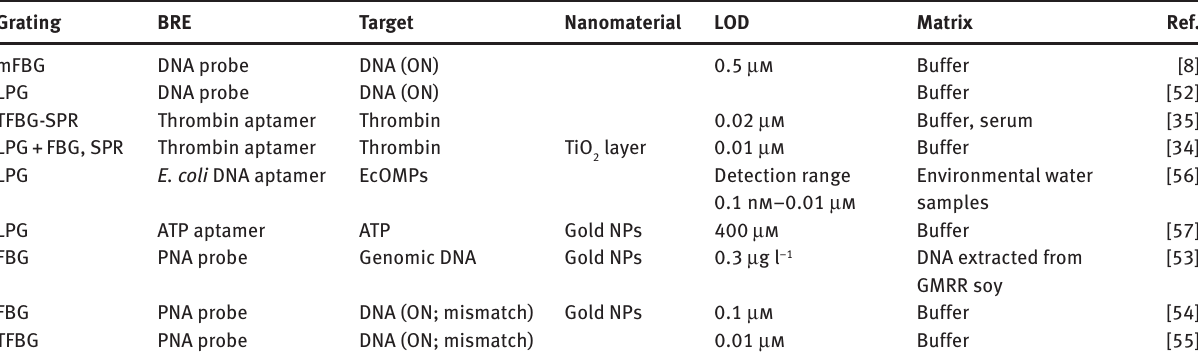
Table 2: OFG-based biosensors with nucleic acids as BREs.